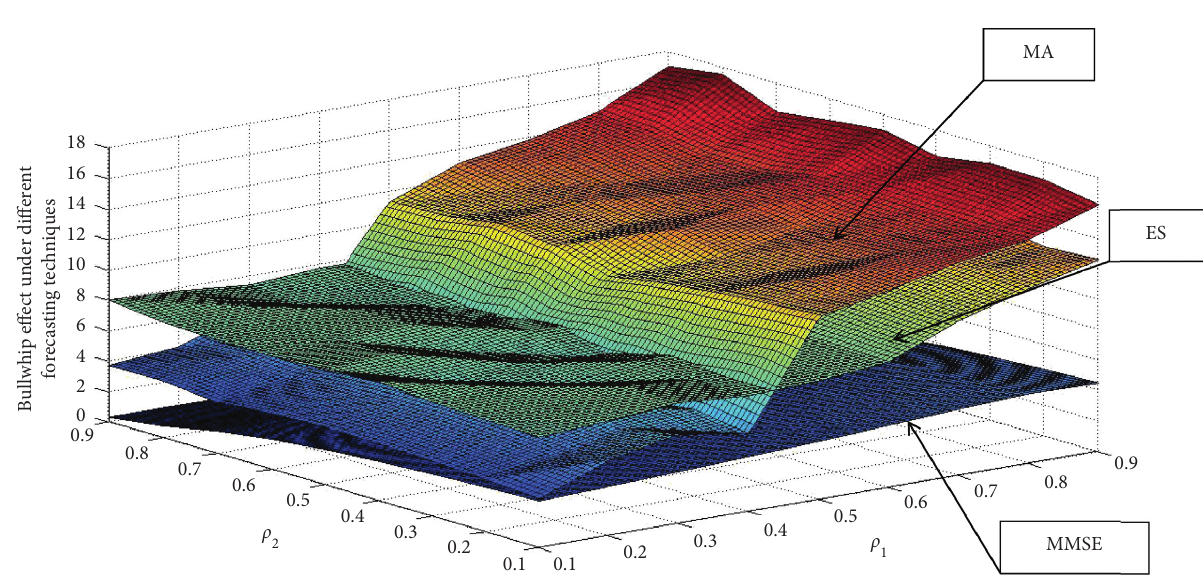
and b on the bullwhip effect using different forecasting techniques. 11 12